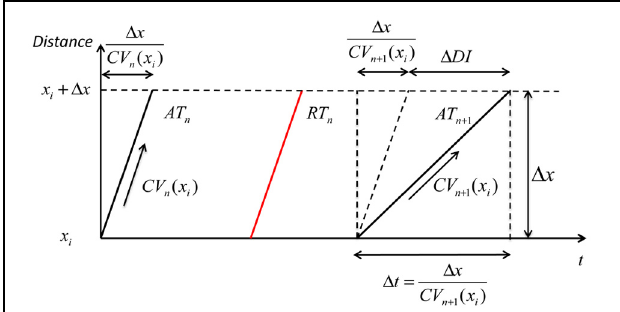
FIGURE 2 | Geometry relationship based on CV restitution. A geometric relationship based on the CV restitution model is shown. x i is the position along a conduction path, (cid:2) DI is the change in diastolic interval, (cid:2) t is the time that an activation wave takes to travel the distance (cid:2) x . AT n : steady-state activation time with long DI; RT n : steady-state repolarization time; AT n + 1 : activation time of an early beat with shorter pacing interval and consequently showing some CV decrease ( CV n + 1 ( x i ), but as the distance over which this operates ( (cid:2) x ) is very small this can be considered as a straight